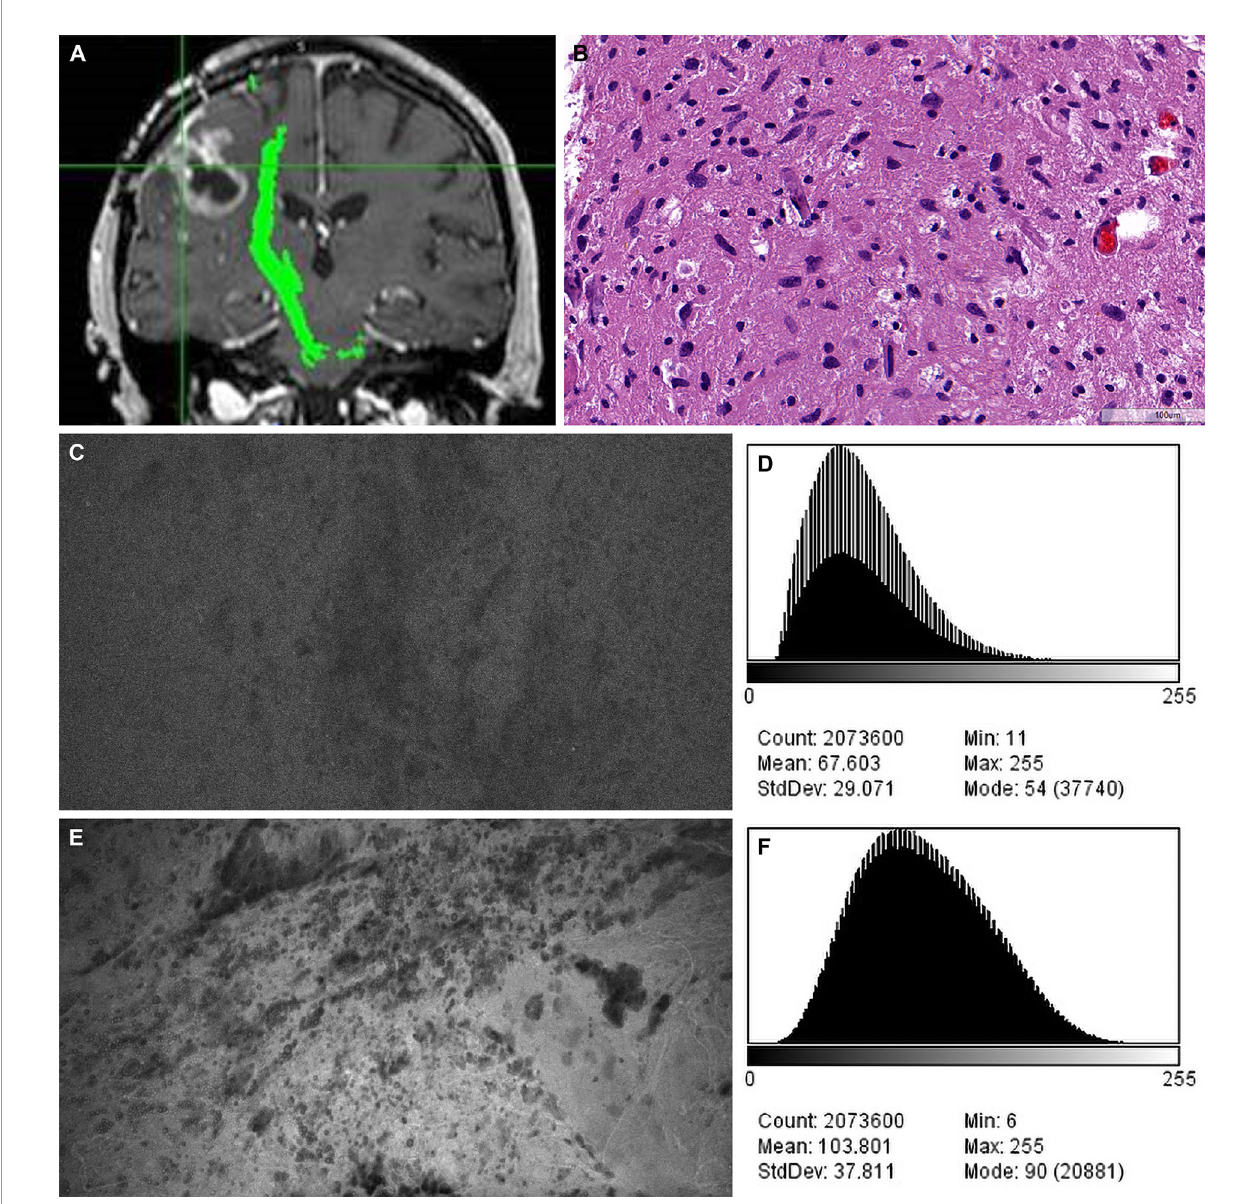
FIGURE 5 | Case example of confocal laser endomicroscopy (CLE) images acquired after fl uorescein sodium (FNa) redosing. (A) Coronal T1-weighted magnetic resonance image with contrast. Biopsy specimens were obtained from the enhancing tumor in the left frontal lobe. (B) A diagnosis of high-grade glioma was made on the basis of H&E staining of the biopsy specimens. (C) A CLE image acquired 95 minutes after initial FNa injection lacks clarity and was regarded as noninterpretable. (D) A histogram corresponding to the image in C shows intensity values of the CLE image acquired after the initial FNa dose. (E) A marked increase in brightness and contrast of the CLE image was observed after FNa redosing. (F) A histogram corresponding to E shows the intensity values of the CLE image acquired after FNa redosing. Count, number of pixels; Mean, brightness; StdDev, contrast; Min and Max, minimum and maximum gray values within the image; Mode, most frequently occurring gray value within the selection corresponds to the highest peak in the histogram. Used with permission from Barrow Neurological Institute, Phoenix,